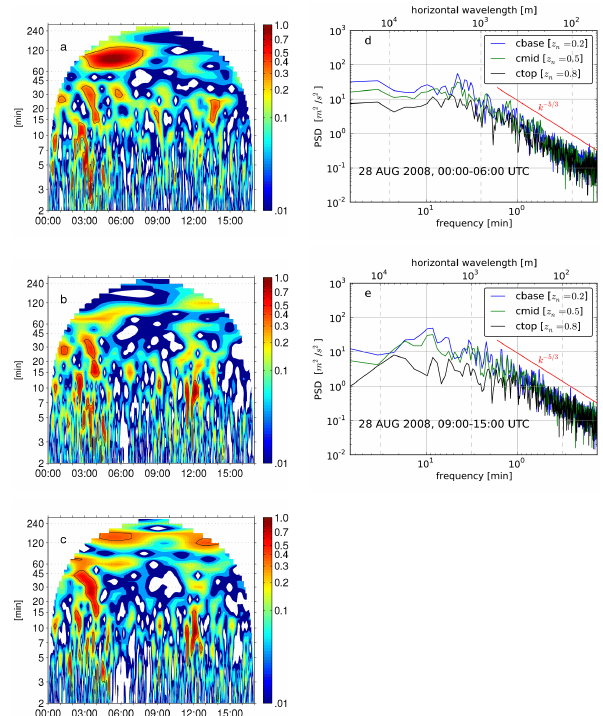
Fig. 7. Normalized w wavelet evolution (contours, 1 is maximum observed w variance; note logarithmic color scale) as a function of frequency scale (ordinate [min]) for 00:00–17:00UTC on 28 Au- gust (hours, abscissa) for (a) cloud top ( z n = 0.8), (b) cloud mid- dle ( z n = 0.5) and (c) cloud base ( z n = 0.2). Wavelet spectral peaks that are statistically significantly (98% confidence level) different than the theoretical red-noise background spectrum, calculated us- ing the lag1 autocorrelation coefficients, have black contour lines. The right panels show the absolute (non-frequency scaled) power spectral density (PSD) of cloud-level (colors) w [m 2 s − 2 ] as a func- tion of frequency (lower axis [min]) and effective horizontal wave- length (upper axis [m]) for subsets of the case period: (d) 00:00– 06:00UTC and (e)